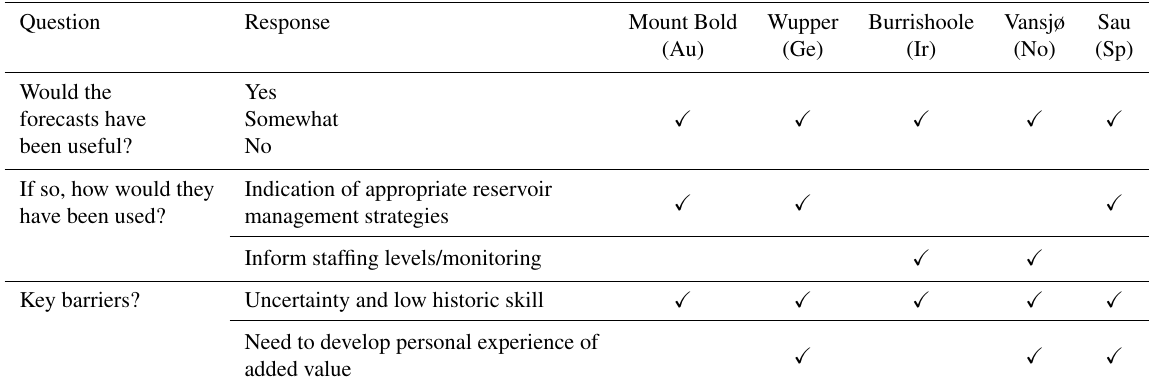
Table 4. Aggregation of water manager feedback on the usefulness of forecasts for the chosen historic seasons. Question